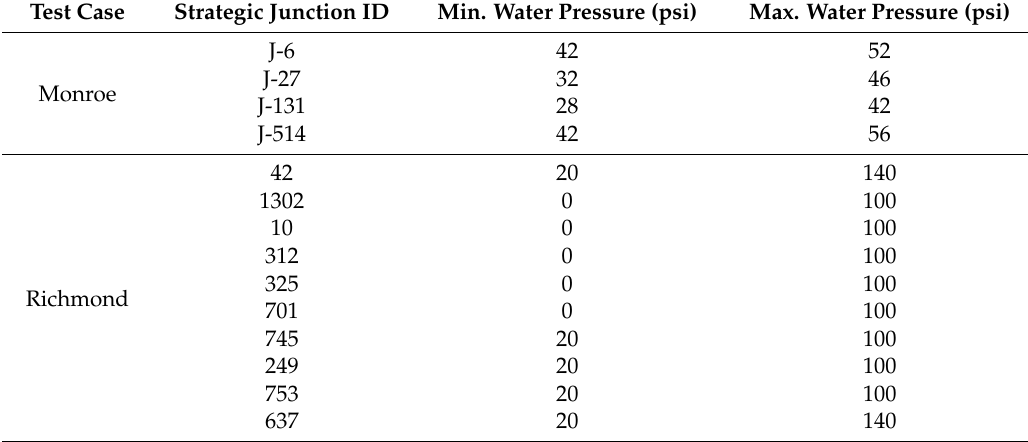
Table 2. Water pressure constraints for strategic junctions of Monroe and Richmond WDS models.